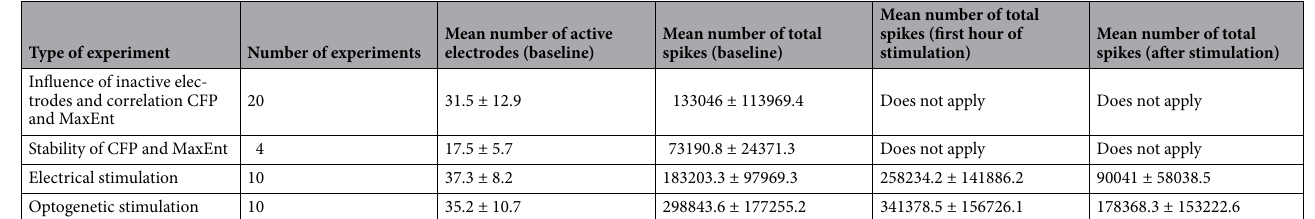
Table 1. Characteristics of networks used in experiments. Second column shows the number of cultures used per type of experiment, third column shows the number of active electrodes in the first hour of spontaneous activity (mean ± SD). The three columns on the right show the number of action potentials recorded during baseline (1 h), the first hour of stimulation, and 1 h of spontaneous activity after stimulation (mean ±